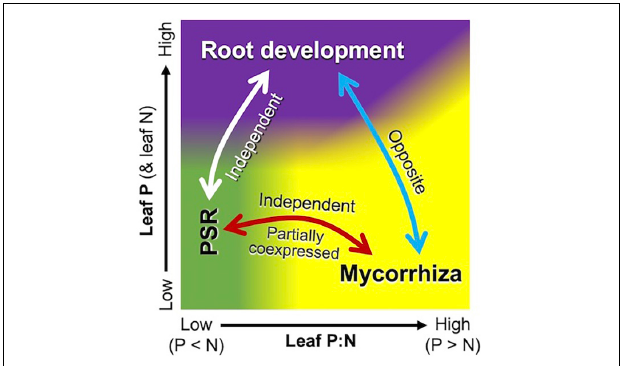
FIGURE 5 | Schematic representation of interplay among the mycorrhizal (yellow area), PSR (green area), and root development (purple area) modules with respect to plant nutrient status. Leaf P:N ratios mainly drive the mycorrhizal module positively and the PSR module negatively, although parts of the genes in the two modules are coexpressed. Higher leaf P (and N) concentrations upregulate the root development module and downregulate the mycorrhizal module, but N deficiency under P-sufficient conditions leads to higher P:N ratios and thus upregulates the mycorrhizal